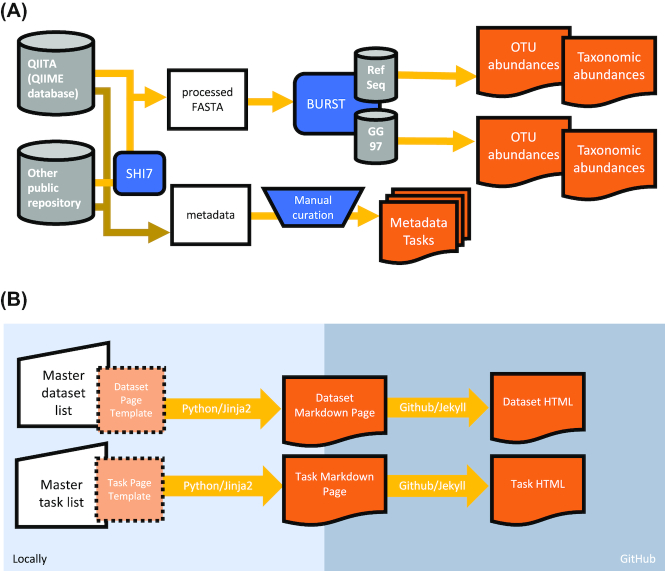
Data processing workflow and website generation. (A) Quality-filtered sequences were obtained from either the QIITA or from another public repository and trimmed and filtered using SHI7. Reference-based OTUs were picked using BURST with the NCBI RefSeq and Greengenes 97 (GG 97) databases. (B) Individual GitHub Markdown pages were generated from dataset and task lists with a custom Python script and Jinja2 template, then uploaded to GitHub to be hosted.